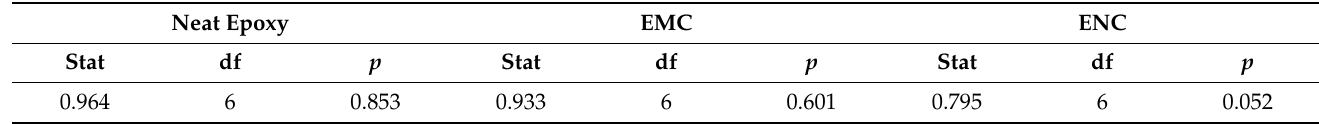
Table 2. Shapiro–Wilk normalization test